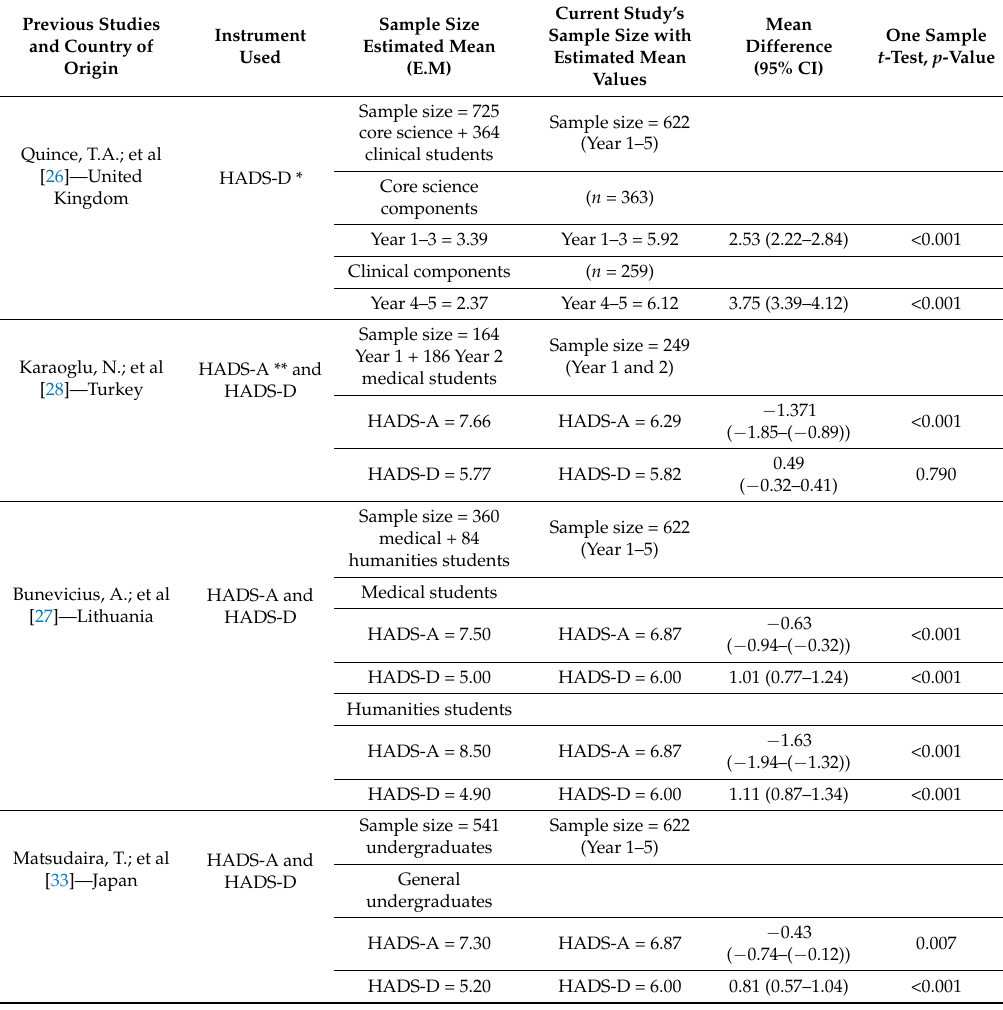
Table 4. Comparative mean of anxiety and depressive symptoms among Malaysian medical students with similar studies from other